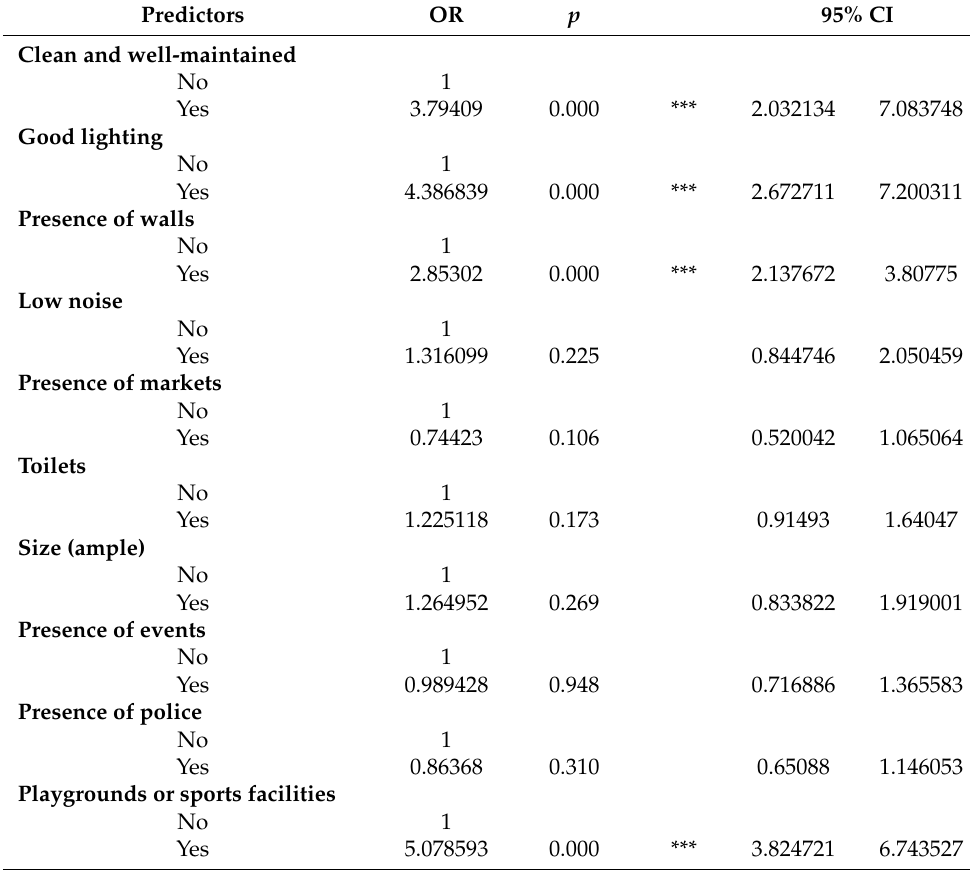
Table 3. Model 4: Odds ratios and 95% confidence intervals for predictor variables associated with perceived good quality of UGS in the neighborhood after COVID-19 restrictions were introduced, online survey of women living in Mexico City ( n = 1245), June 2020. Predictors OR p 95% CI